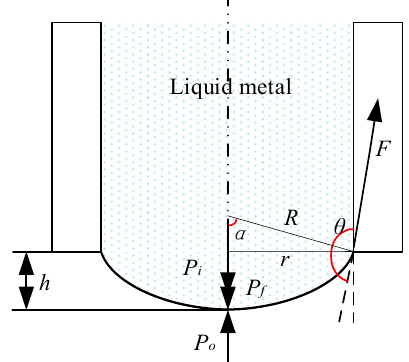
Figure 2. Tip shape of the liquid-metal electrode.